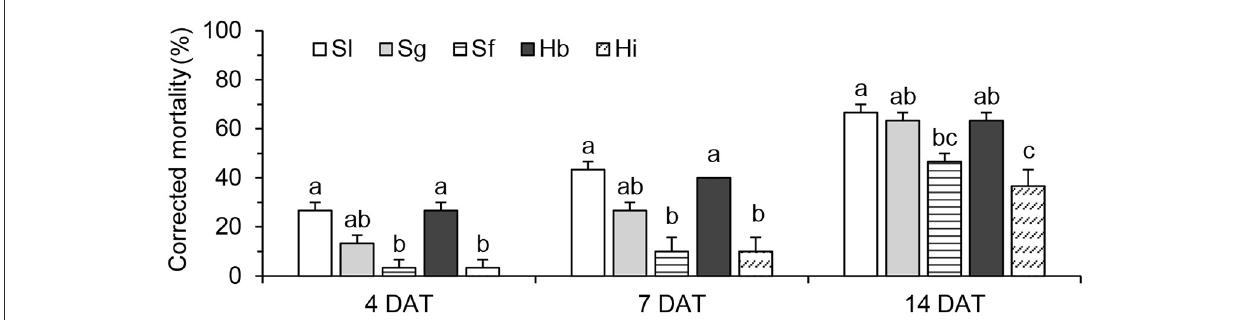
FIGURE1 Corrected mortality of Holotrichia oblita Faldermann treated with Steiernema longicaudum X-7 (Sl), S . glaseri KG (Sg), S . feltiae SN (Sf), Heterorhabditis bacteriophora H06 (Hb), and H . indica LN2 (Hi) evaluated at 4, 7 and 14 DAT. Different letter(s) on the bars represent significant differences among treatments on the same day ( P < 0.05, Tukey’s test).